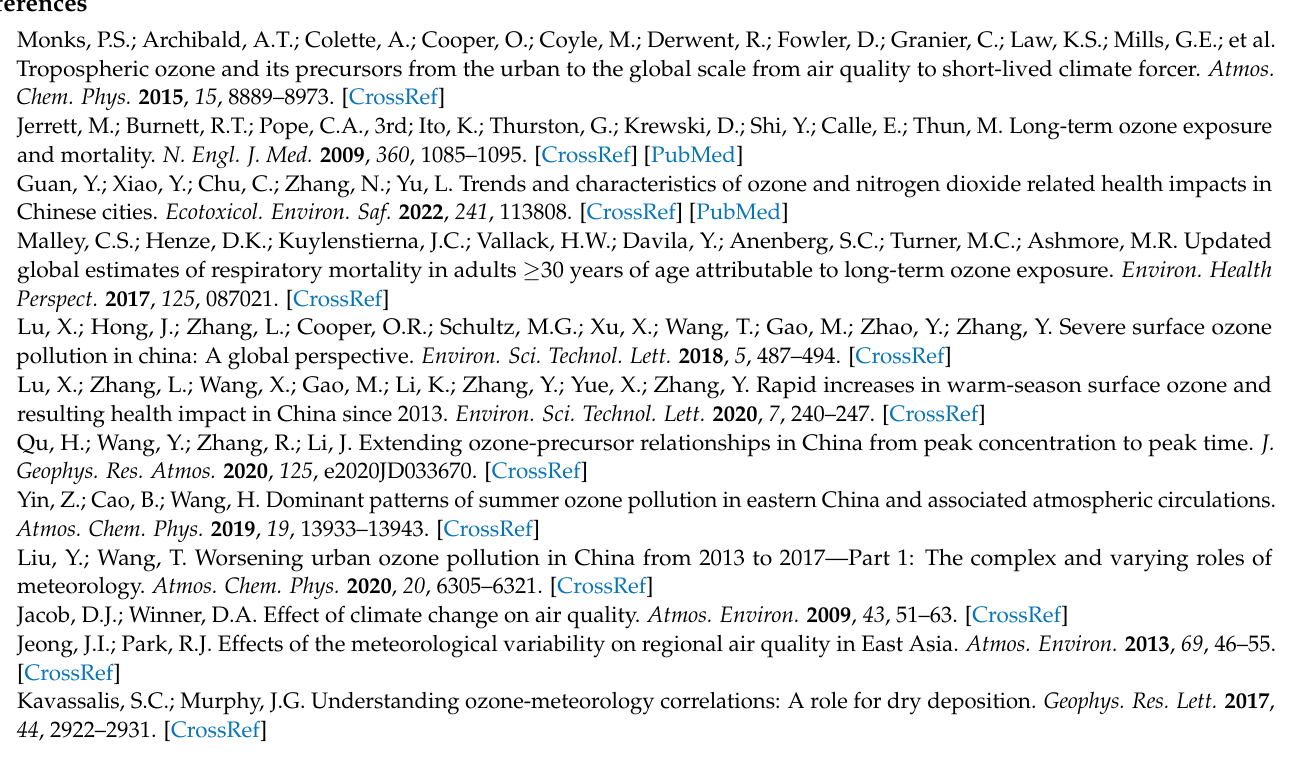
Figure S2: The difference in seasonal averaged daily mean temperature (top), relative humidity (middle) and wind speed (bottom) between the two years; Table S1: The parameters used as input in AirQ+ software for Guangdong and Jiangsu province during the wet and the dry year. Reference [37] are cited in the supplementary